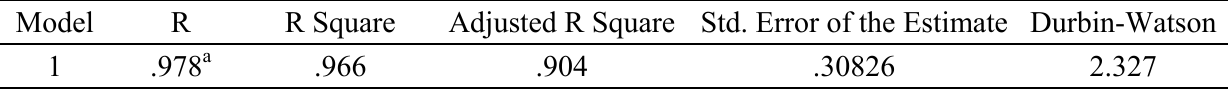
The summary of basic statistical observation on regression analysis Model